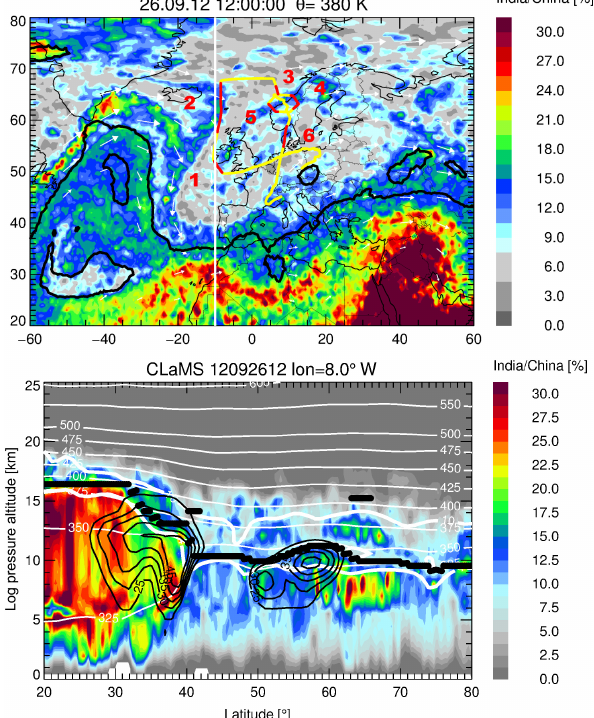
Figure 8. Horizontal cross section of the fraction of air originating in India/China over Europe on 25 September at 370K (top) and on 23 September 2012 at 380K (bottom). The flight paths transferred to noontime for the TACTS/ESMVal flights 2012 over northern Eu- rope are marked as yellow lines. Segments of the flight in the lower stratosphere with enhanced measured CO, CH 4 , and H 2 O, and re- duced O 3 compared to the stratospheric background are highlighted in red and numbered for clarification (the same numbers are used in Figs. 10 and 11). The climatological isentropic transport barriers of 6.0PVU (at 370K) and 7.2PVU (at 380K) are shown as thick black